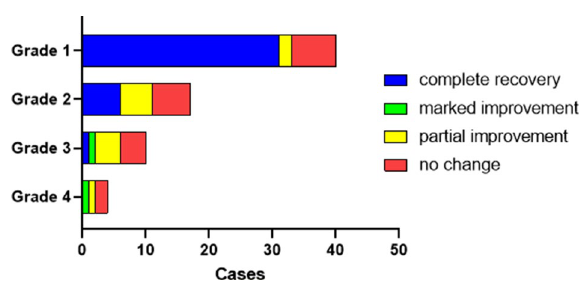
Figure 2. Frequency distribution of severity of hearing loss (Grade 1–4) in the first sudden sensorineural hearing loss episode and outcomes of each grade (n = 71 episodes). The degree of recovery (complete recovery, marked improvement, partial improvement, or no change) decreased with increasing hearing-loss severity, a trend that was significant as revealed by the Cochran-Armitage trend test ( P = 0.0000020). This bar chart was created using GraphPad Prism 9.0.0 for Windows, GraphPad Software, San Diego, California USA, www. graph pad.